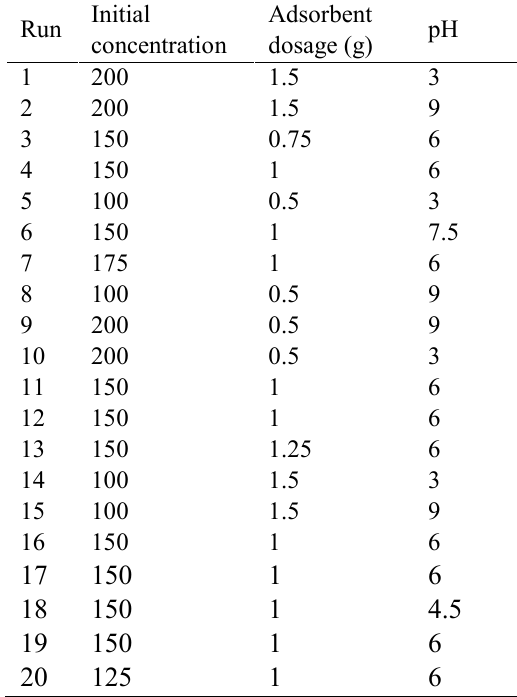
Table 1. Experimental condition designed by Design Expert